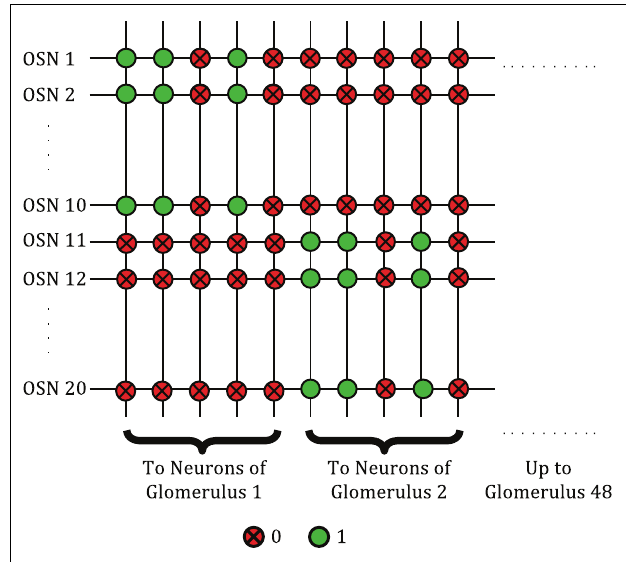
FIGURE 4 | Crossbar connectivity depicting the convergence of OSNs expressing the same receptor type to the same glomerulus. A total of 48 distinct glomerular columns are implemented in one core.